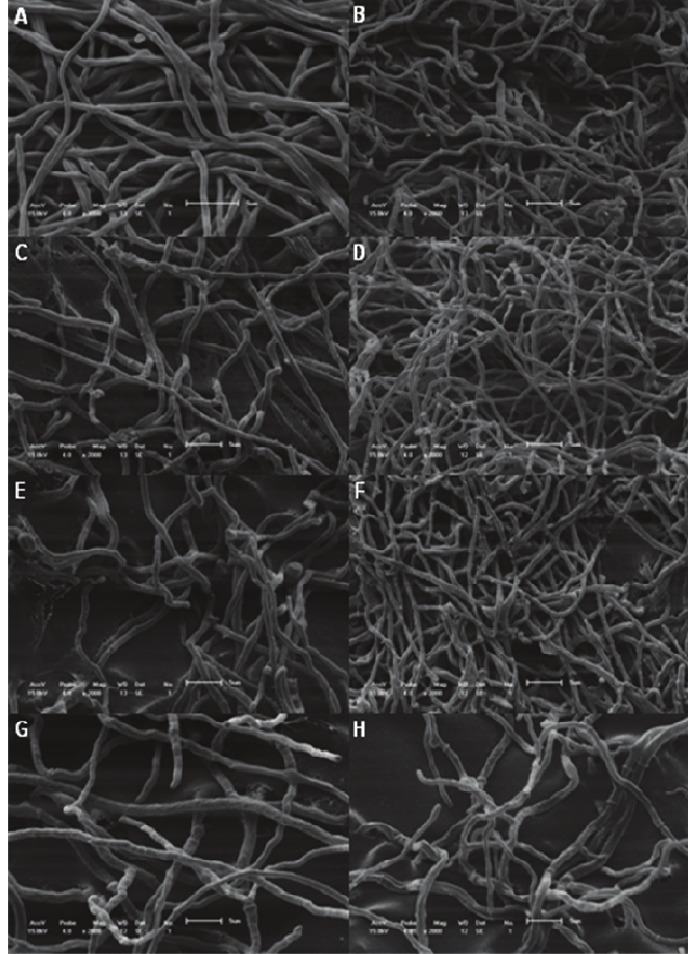
Figure 4. Scanning electronic microscopy of Trichophyton rubrum treated with different concentrations of fraction in nail laquer. A and B = control; C and D= nail lacquer without fraction; E and F= nail lacquer with 1.25 mg of chloroform fraction; G and H= nail lacquer with 5 mg of chloroform fraction. C, E and G= samples taken near the nail lacquer; D, F and H=samples taken far the nail lacquer. Magnification: 3000× (A) and 2000× (B – H). Bars 5